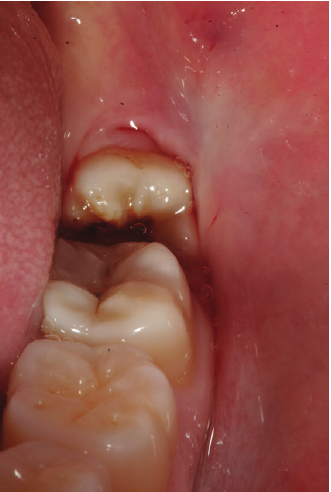
Figure 1: Preoperative clinical view.